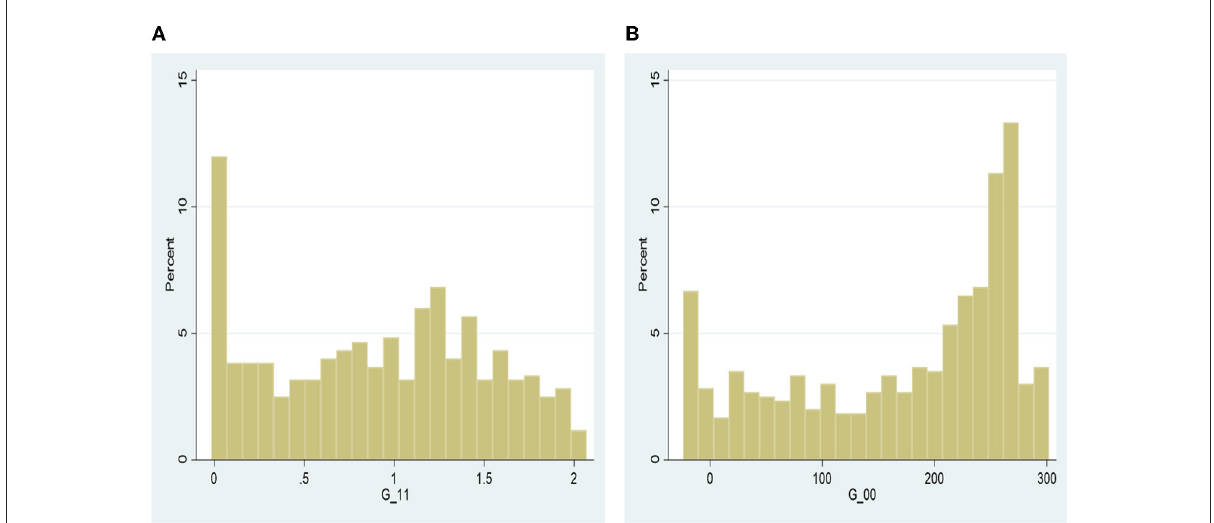
FIGURE6 Comparison of yield (Kg/Ha) distributions at the inefficiency frontier—direct effect. (A) Mediated-adopters, (B) no-mediated-non-adopters.